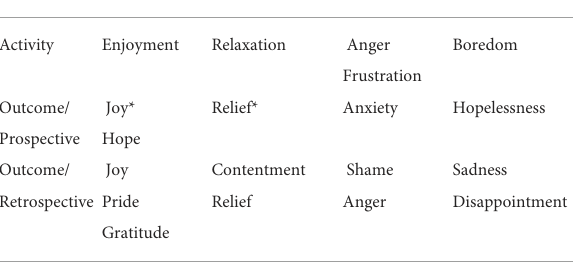
TABLE 1 A three-dimensional taxonomy of achievement emotions (Adapted from Pekrun and Stephens,